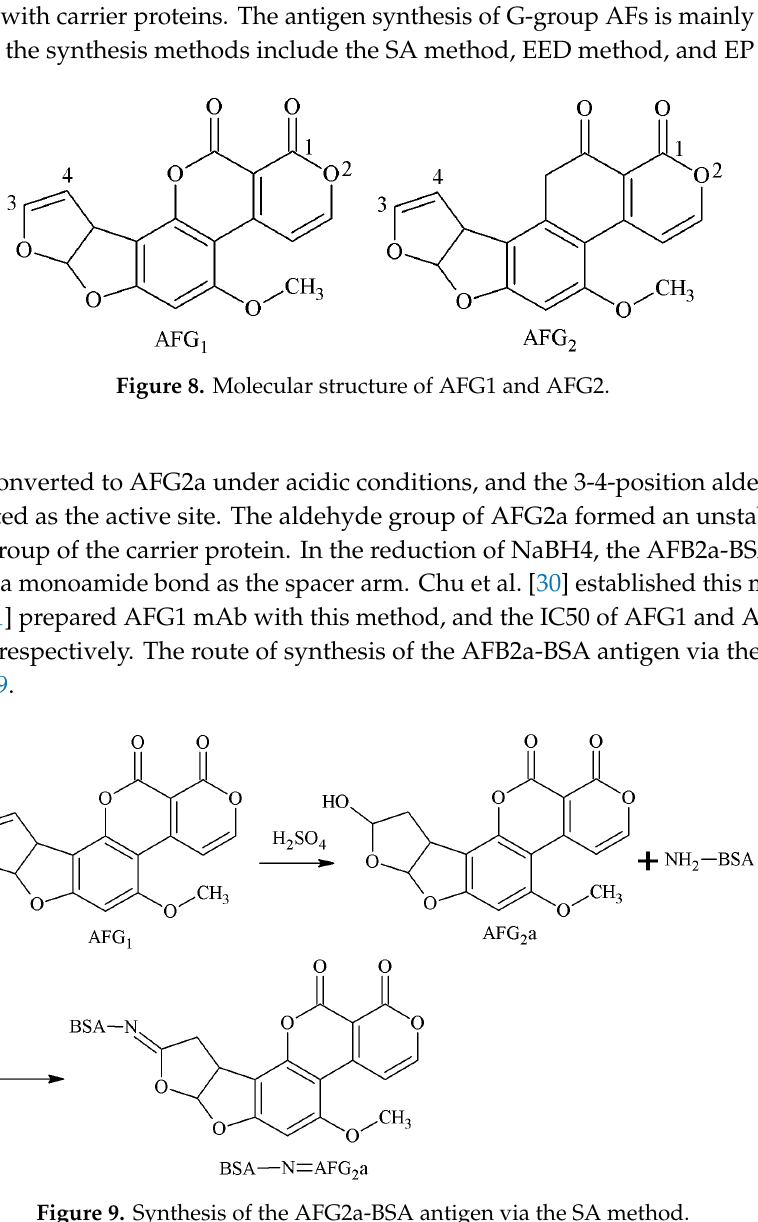
Figure 10. Synthesis of the AFG1-BSA antigen by the EP method. 2.2.3. EED Method The 3-4-position double-furan ring of AFG1 was selected as the active site, and the AFG1 enol ether derivatives (AFG1-GA) were obtained by adding glycolic acid junction arm, and the AFG1-GA carboxyl group was used to synthesize the antigen AFG1-BSA with BSA amino groups. Lyer et al. [33] established this method in 1993 and prepared AFG1 pAb and AFG1 mAb. These antibodies could identify AFG1 and AFG2 100% and had no CR with AFB1 and AFB2. However, the sensitivity of the